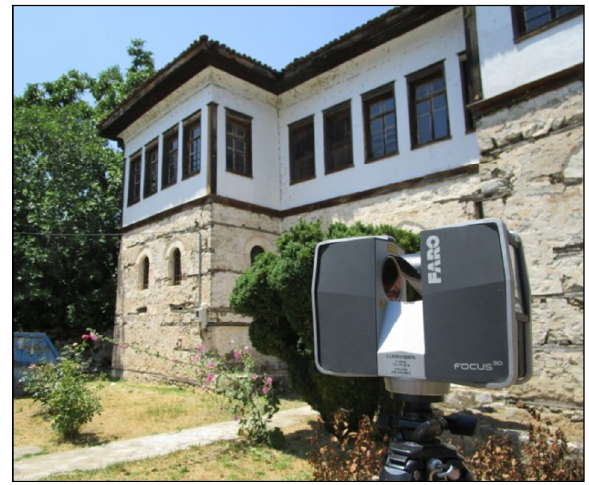
Figure 7. FARO Laser Scanner (image taken by the author).